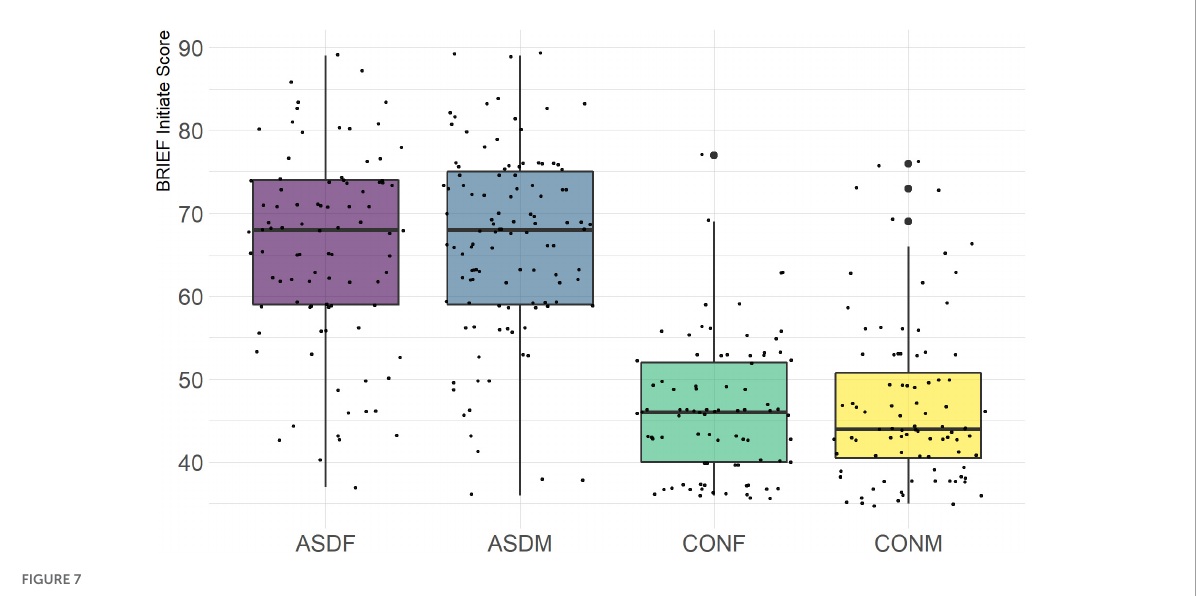
FIGURE7 BRIEF Initiate